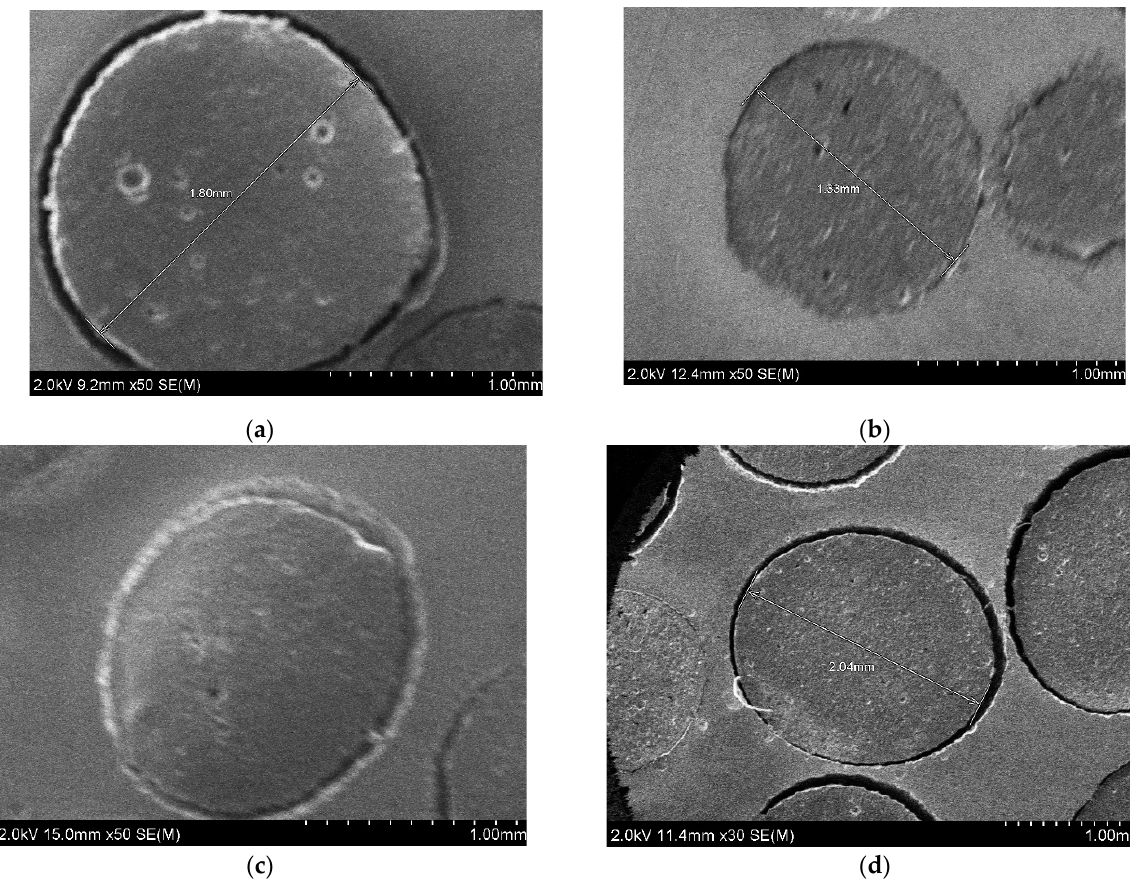
Figure 10. SEM capsule images: ( a ) Alg 70:Fe30; ( b ) Alg 50:Fe 50; ( c ) Alg 30:Fe 70; ( d ) Alg 20:Fe 80. Figure 11 illustrates the bitumen rejuvenating pockets within the capsule structure.